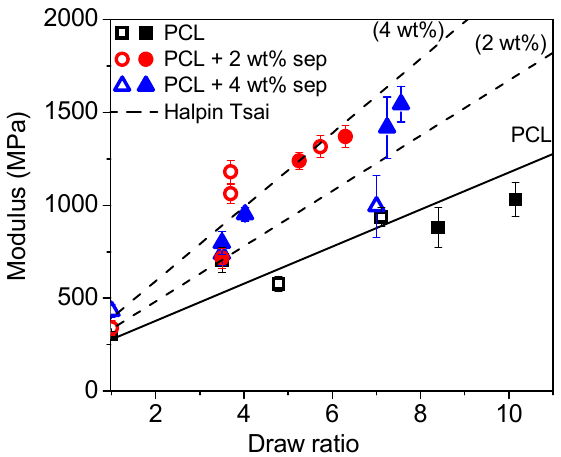
Figure 16. Modulus as a function of the draw ratio. Open symbols represent samples cooled with open chill rolls. Closed symbols represent samples cooled with closed chill rolls, corrected for matrix pre-orientation. The solid line shows the increase in modulus for neat PCL. The dotted lines show Halpin-Tsai predictions for l/d = 10. The filler is assumed to be uniaxially oriented in the direction of the drawing.